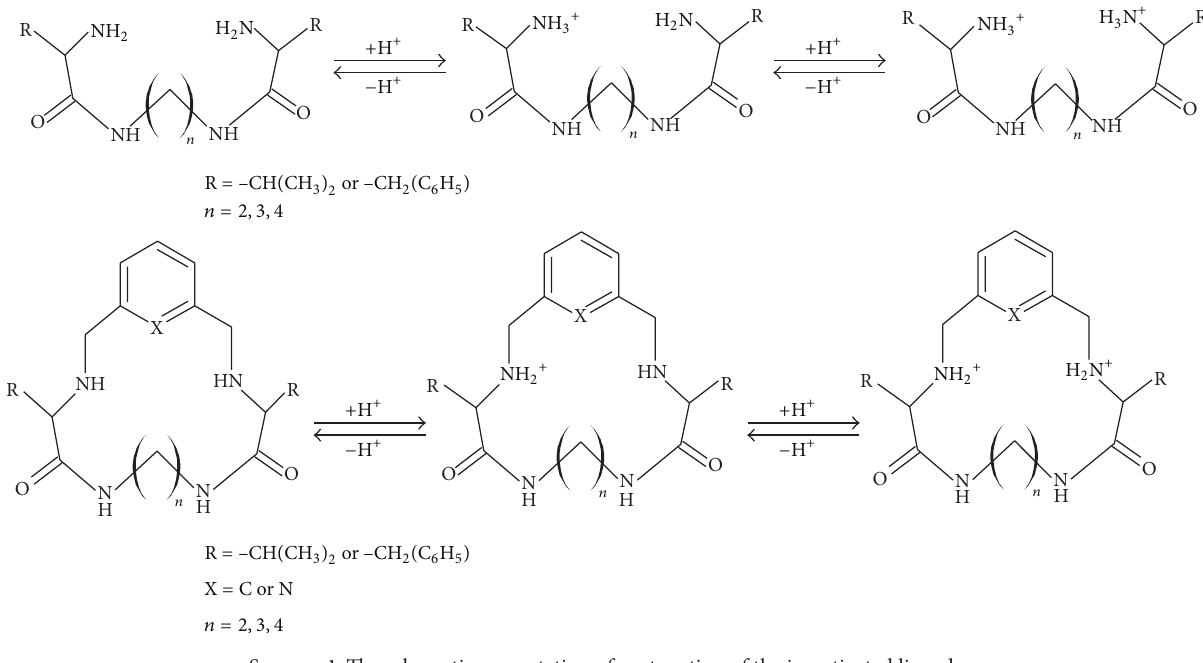
Scheme 1: The schematic presentation of protonation of the investigated ligands.